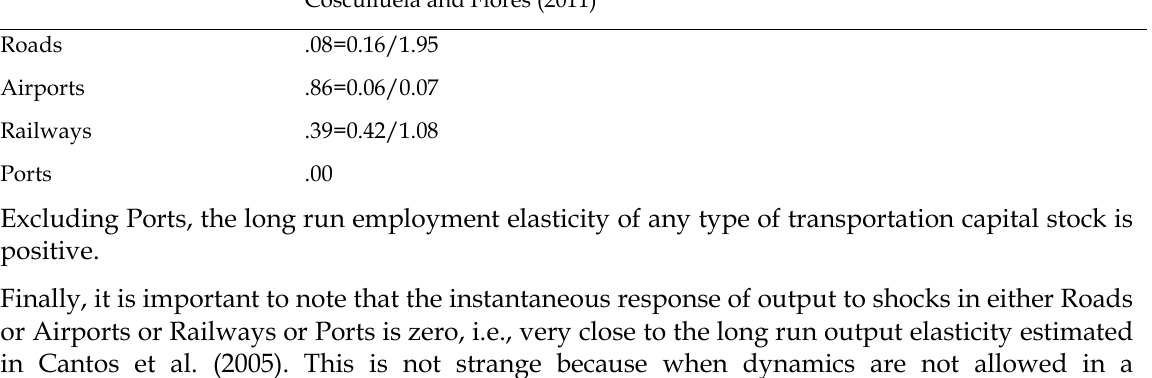
Table 2. Long Run Employment